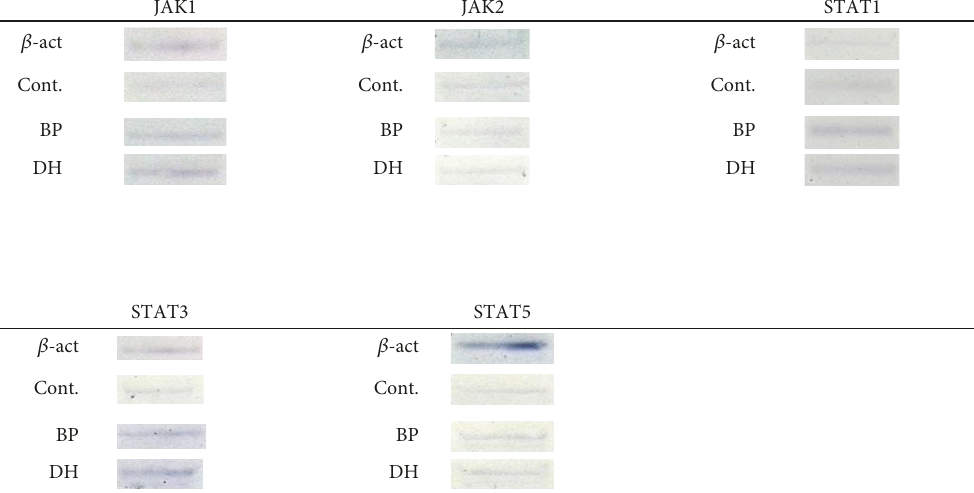
Figure 1: Expression of JAK1, JAK2, STAT1, STAT3, and STAT5 in epidermis, evaluated with Western blot. β -act — positive control. Cont. — control group, normal skin. BP — skin lesions, bullous pemphigoid. DH — skin lesions, dermatitis